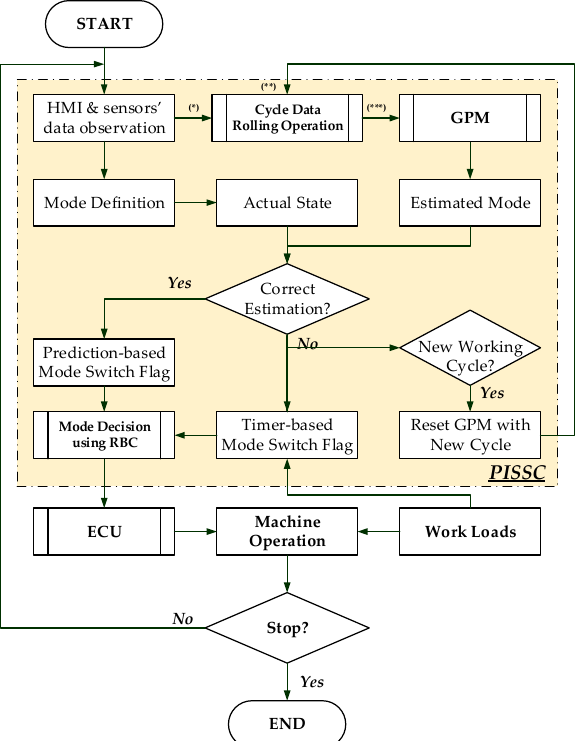
Figure 5. PISSC-based engine working principle. *; ** and *** denote signals entering ‘Cycle Data Rolling Operation’ block. The internal structure of this block is described in Figure 6.